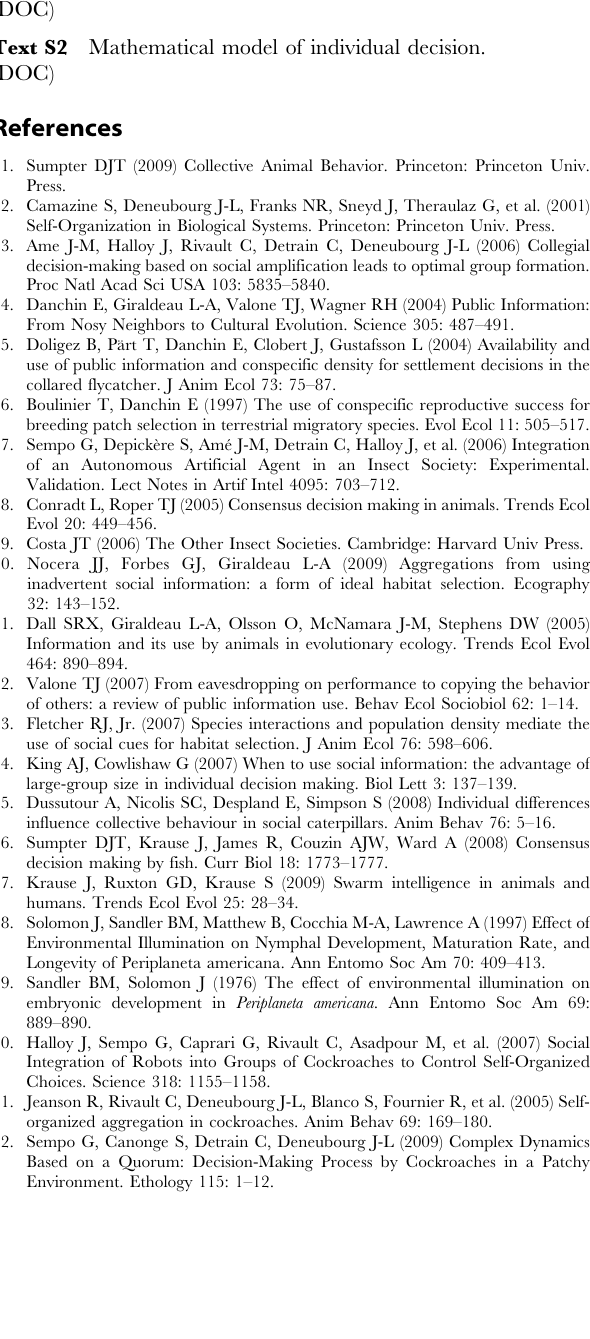
Figure S1 Theoretical and experimental replicate distributions. Table S1 Experimental fraction under shelters. Text S1 Statistical criteria for shelter selection. Text S2 Mathematical model of individual